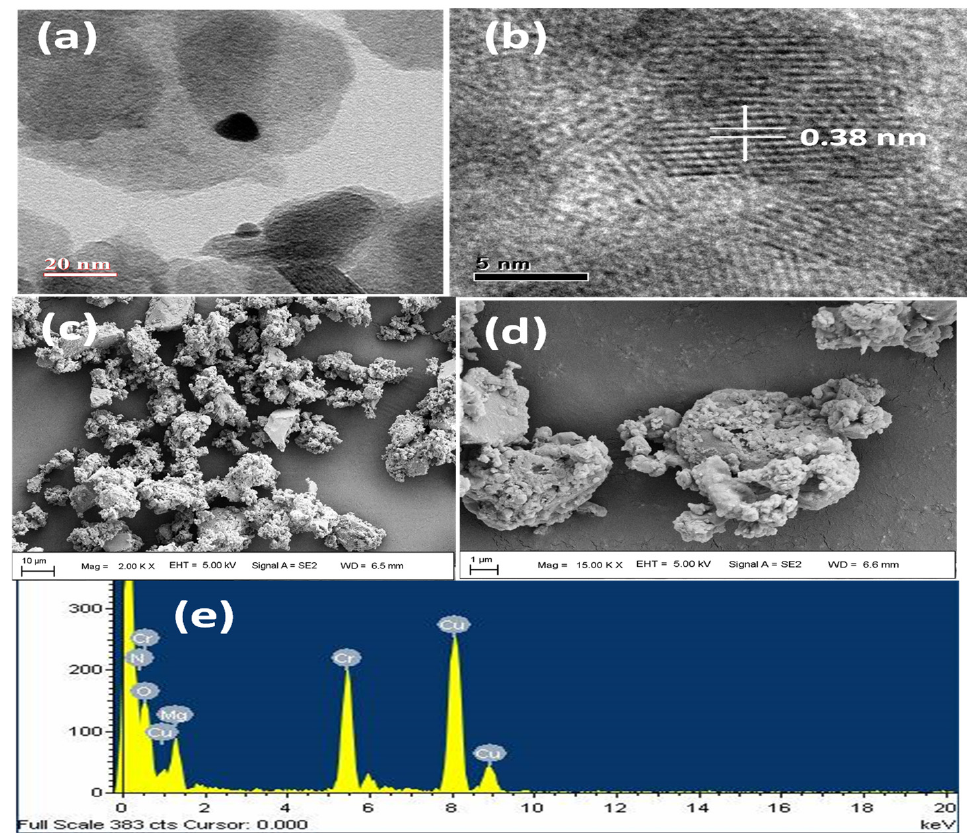
Figure 2. ( a ) TEM morphology of exfoliated MgCr-LDH (3:1, 80 °C), ( b ) lattice fringe of MgCr-LDH (3:1, 80 °C) as detected from HR-TEM image analysis, ( c , d ) FESEM morphology of MgCr-LDH (3:1, 80 °C), and ( e ) EDX spectrum of MgCr-LDH (3:1, 80 °C).